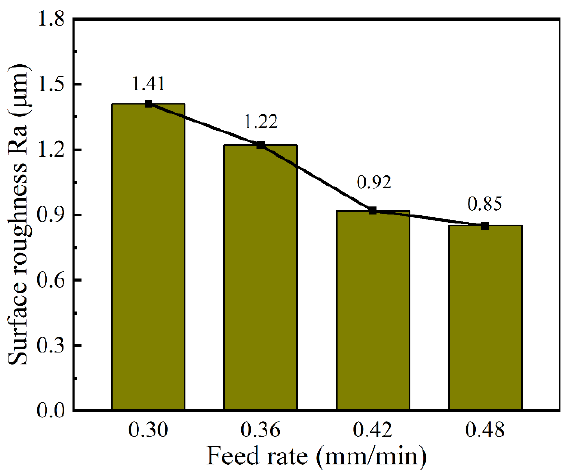
Figure 17. The surface roughness (Ra) of sidewall with varied feed rates.